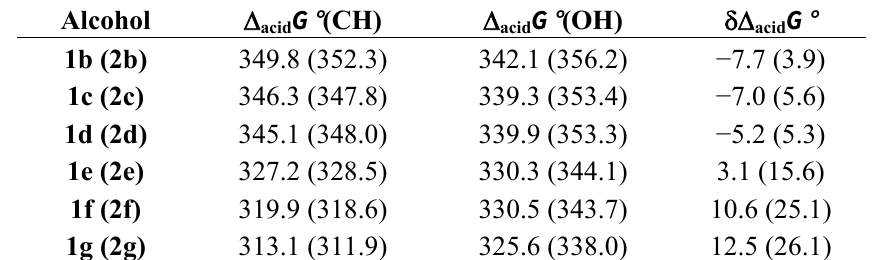
Table 1. Absolute gas phase acidities for alcohols 1b – 2g . Values are reported in